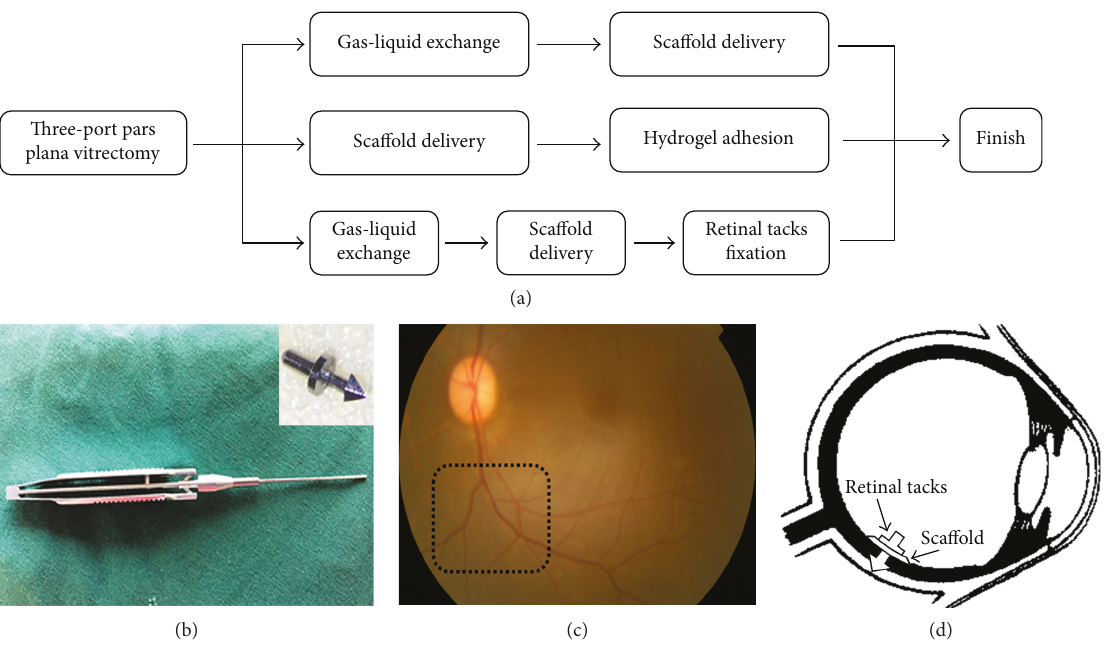
Figure 2: The procedures and equipment for implantation surgery. (a) The surgical procedures of the three di ff erent sca ff old fi xation methods included adhesion after gas-liquid exchange, tamponaded by hydrogel, and fi xed by retinal tacks. (b) Retinal tacking and forceps for the tack insertion. (c) The preset site for the PLGA sca ff old fi xation. (d) Schematic diagram of the PLGA sca ff old fi xation by retinal